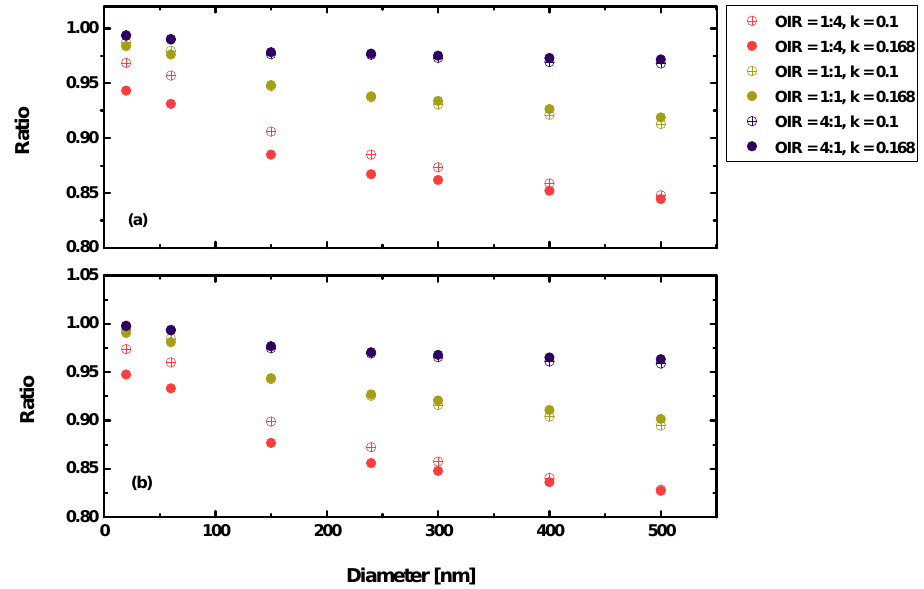
Figure 11. Ratio of radiative forcing of LLPS to the homogenous case under 70%RH (a) and dry conditions (0%RH) (b) for AAE = 2 and albedo a = 1.